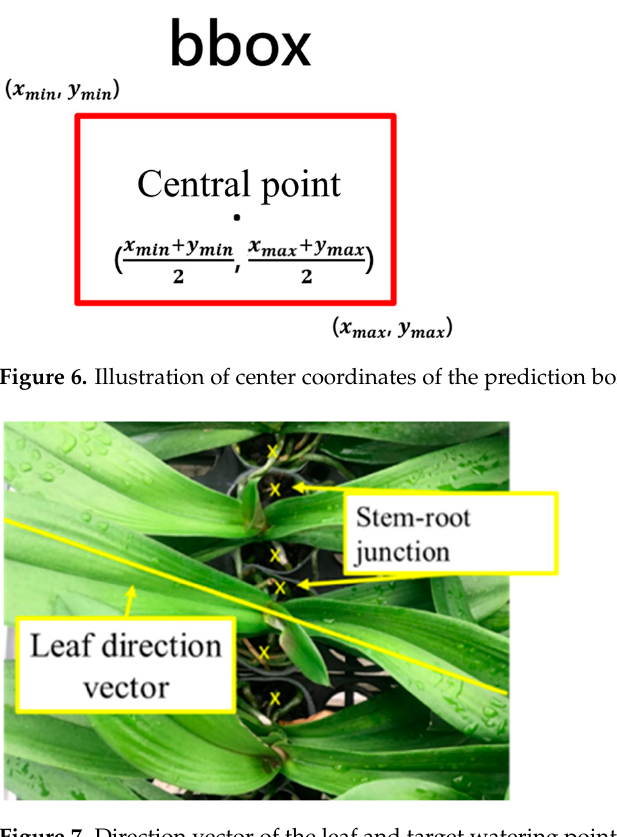
Figure 6. Illustration of center coordinates of the prediction box.